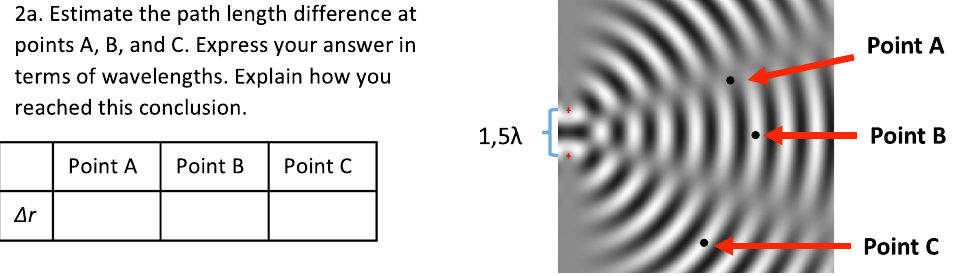
FIG. 1. The test item 2(a), designed to test students ’ ideas about path length